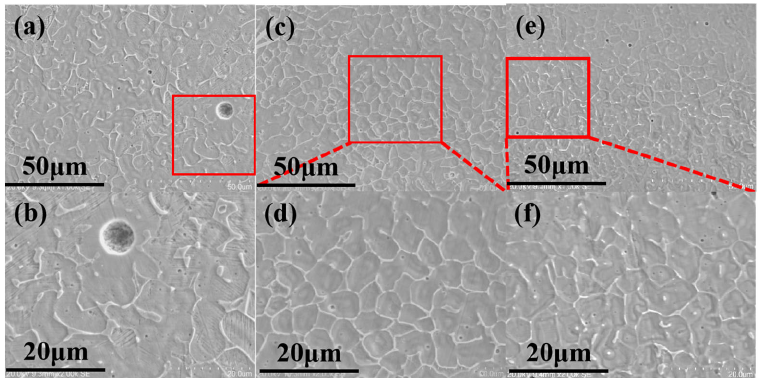
Figure 10. Micromorphology of samples under di ff erent cavity pressures: ( a , b ) 0.3 MPa; ( c , d ) 0.5 MPa; ( e , f ) 1.5 MPa.